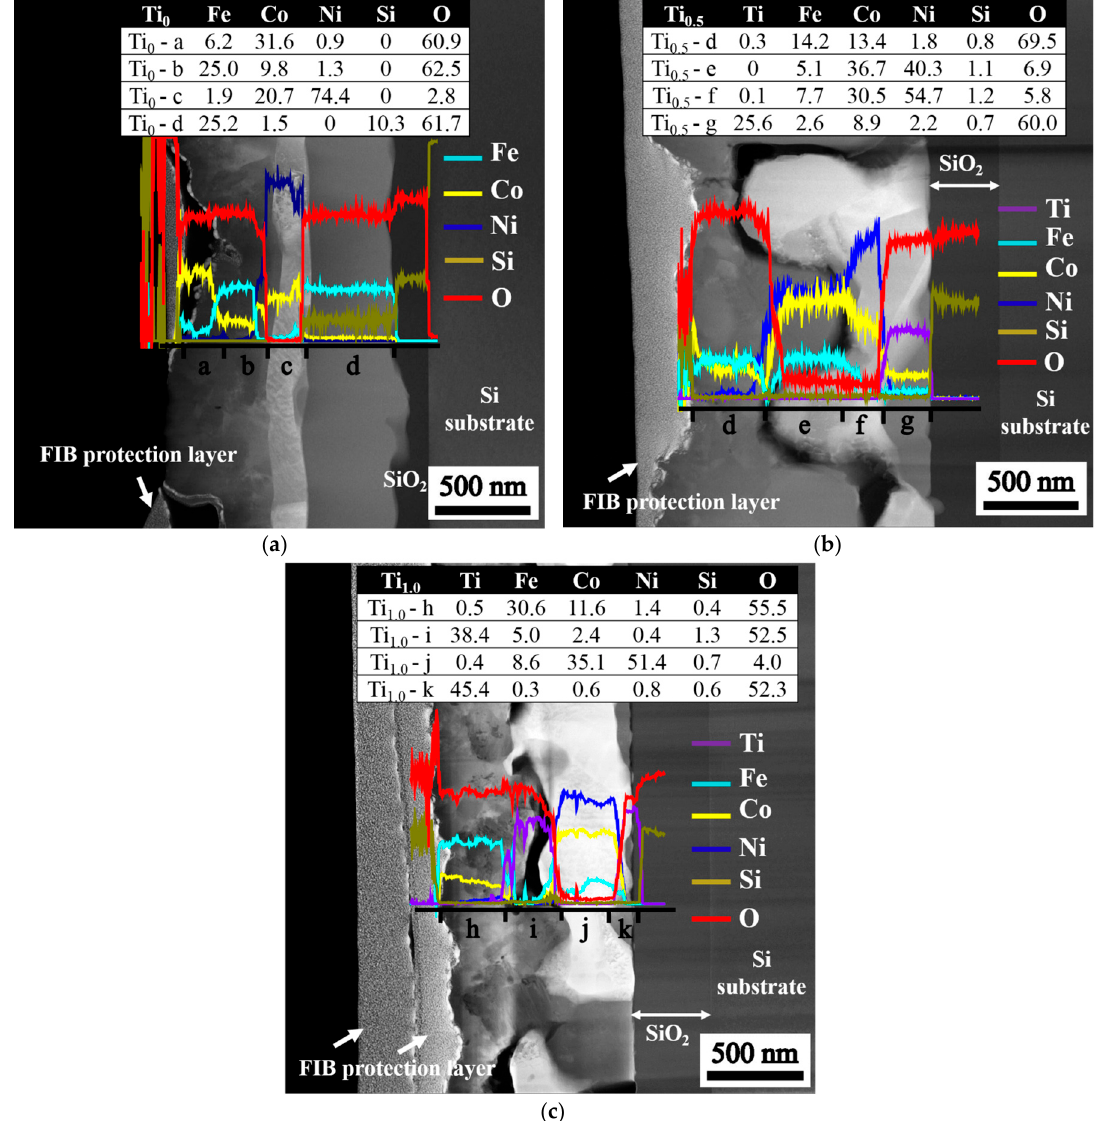
Figure 4. Composition distribution of as-annealed Ti x FeCoNi thin films, as determined using TEM and EDS: ( a ) Ti 0 ; ( b ) Ti 0.5 ; and ( c ) Ti 1.0 films.